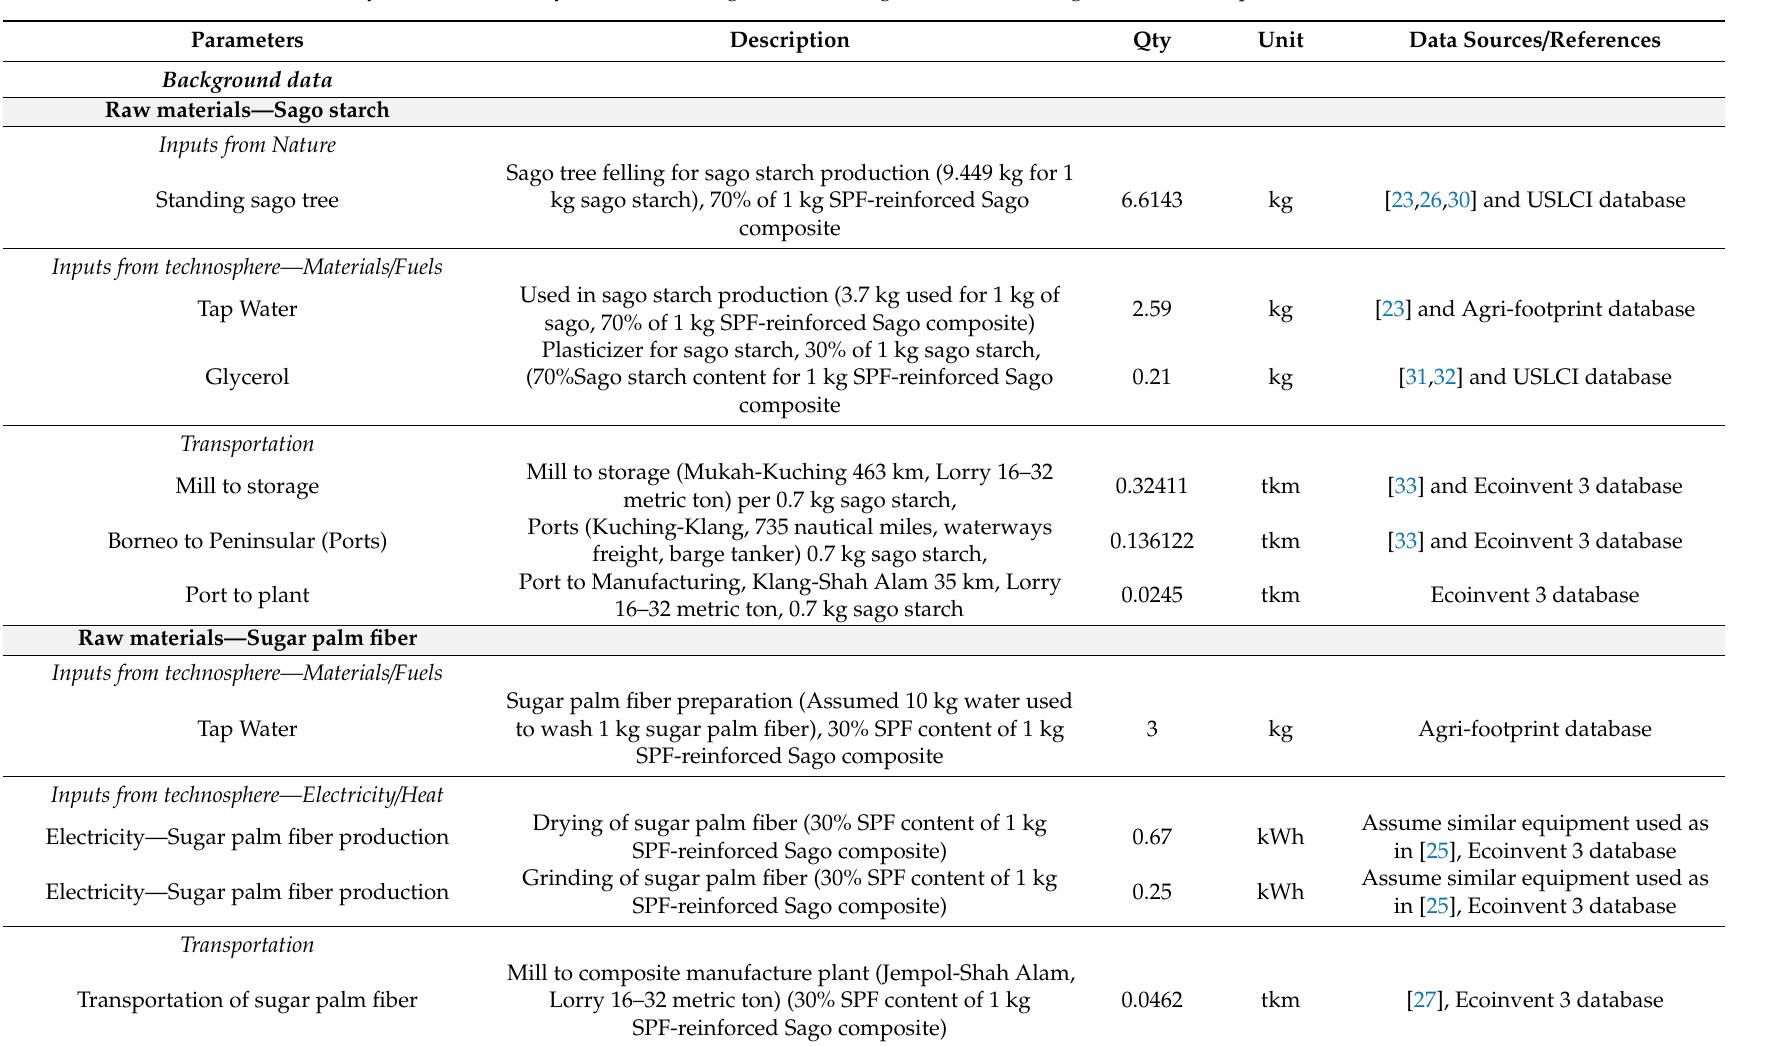
Table 1. Inventory data used to analyze the cradle-to-grave of the 1 kg SPF-reinforced sago starch biocomposite takeout food container.